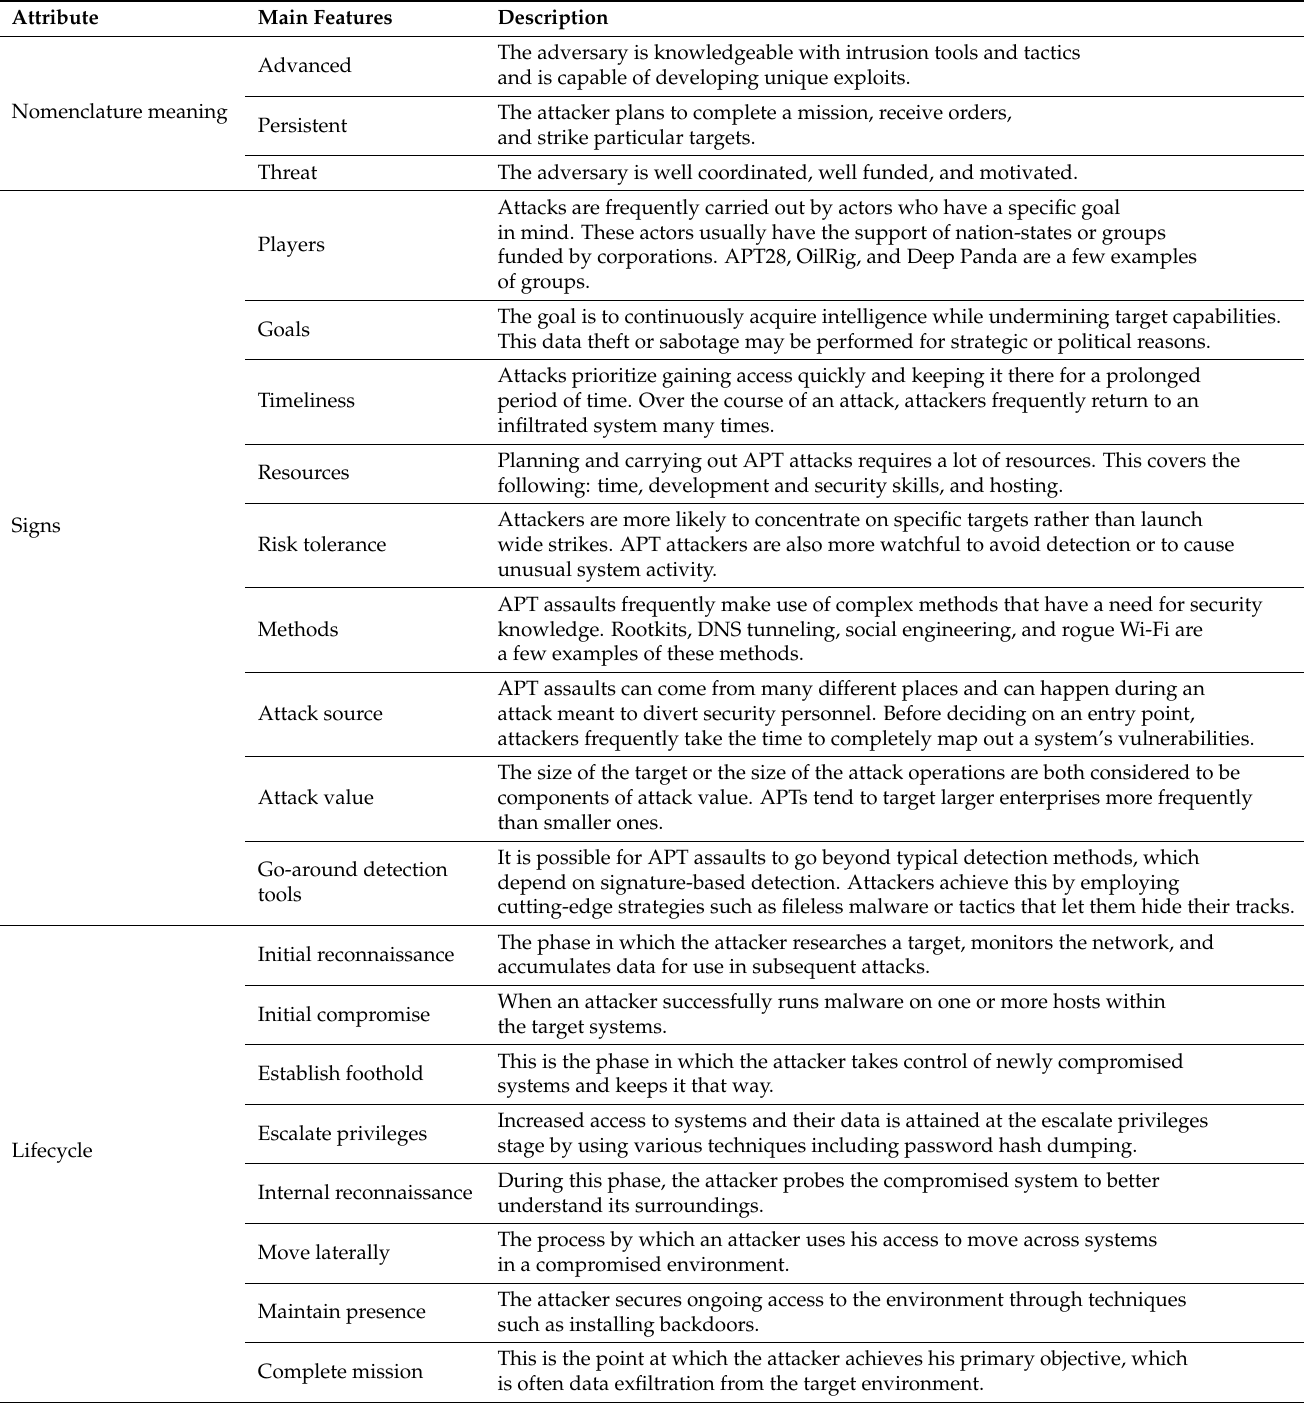
Table 1. Advanced Persistent Attacks’ main characterizing attributes and detection and protection